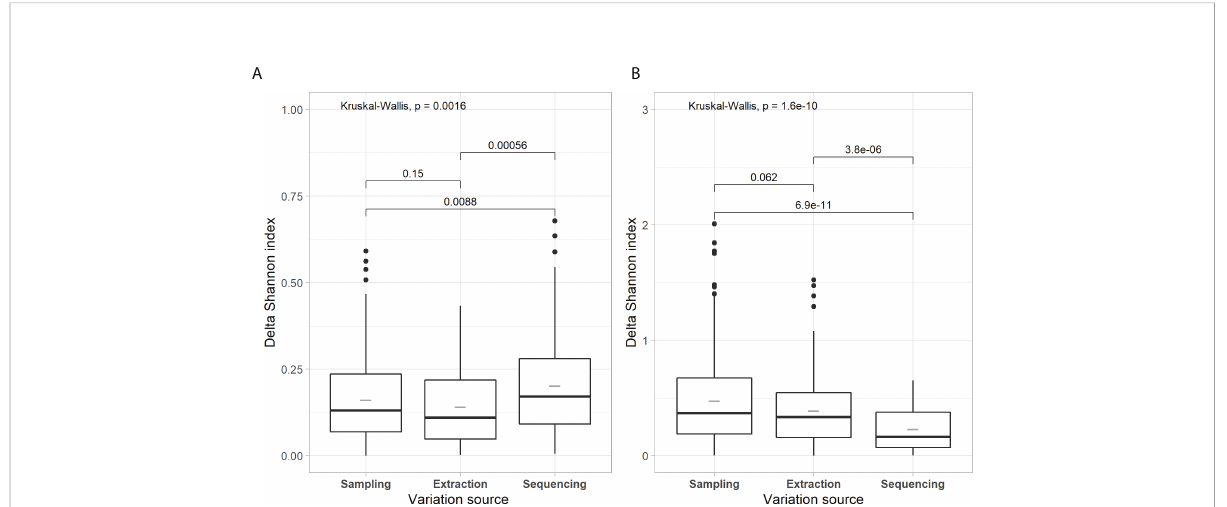
FIGURE 1 Box-and-whisker plots of Shannon diversity for each component of technical variability for prokaryotic (A) and fungal (B) communities. Lower and upper edges of the boxes delimit the 25 th and 75 th percentiles, while the horizontal bar is the median value (50 th percentile) for that variable. The lower and upper whiskers delimit the 10 th and 90 th percentiles, respectively; the fi lled circles are outliers beyond 1.5 x Interquartile Distance (25 th to 75 th percentiles) from the lower and upper edges of the boxes. Kruskal-Wallis rank-based ANOVA compares the sources of variation for each microbial group; pairwise post-hoc comparisons with Wilcoxon-tests indicate which treatment mean ranks differ from one another within microbial